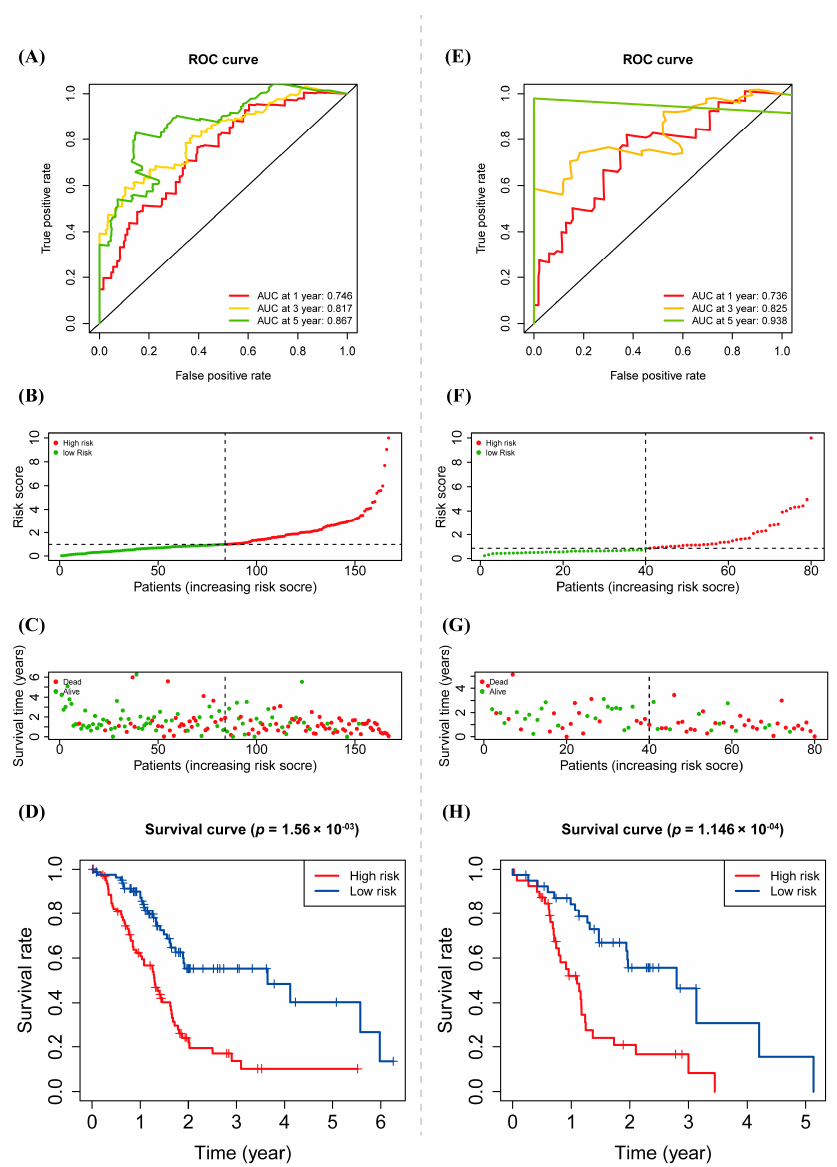
Figure 4. Prognostic value of warlncRNAs signature. ( A ) Time-dependent ROC curves of OS at 1-, 3-, and 5-year with other common clinical features in the training cohort. ( B , C ) Risk scores ( B ) and survival time ( C ) of each sample in the training cohort. ( D ) Kaplan–Meier analysis for OS of PAAD patients based on the risk group in the training cohort. ( E – H ) Prognostic value of warlncRNAs signature in the validation cohort.